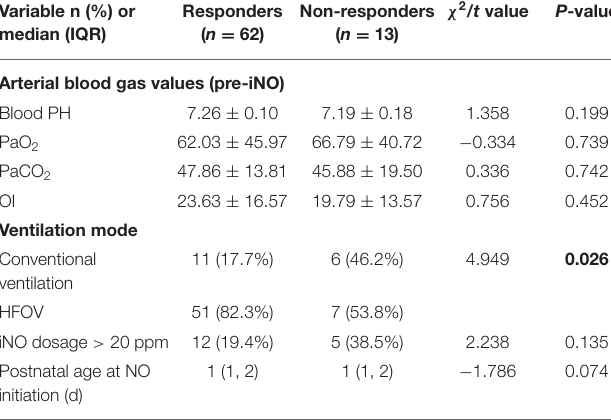
TABLE 2 | iNO treatment variables.